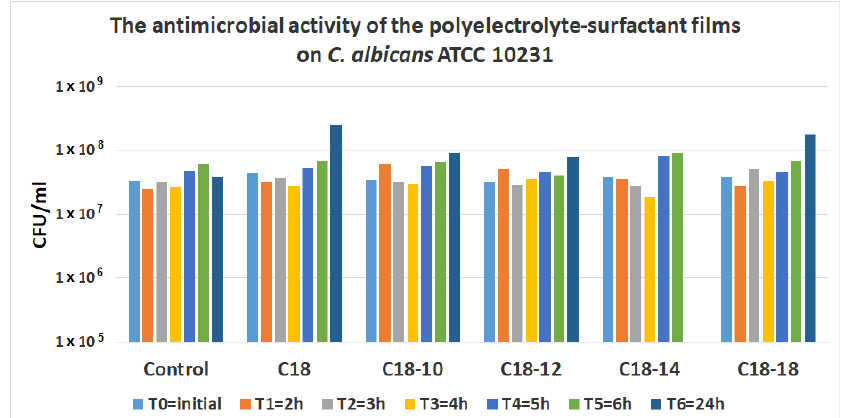
Figure 4. The antimicrobial activity of the polyelectrolyte–surfactant films on Candida albicans ATCC 10231 at di ff erent times of incubation (initial, 2, 3, 4, 5, 6, and 24 h): (control—clear glass, C18-(PAC 18 Na / PDADMAC) 20 , C18-10-(PAC 18 Na-C 10 TAB / PDAMAC) 20 , C18-12-(PAC 18 Na-C 12 TAB / PDAMAC) 20 , C18-14-(PAC 18 Na-C 14 TAB / PDAMAC) 20 , and C18-18-(PAC 18 Na-C 18 TAB / PDAMAC) 20 ).